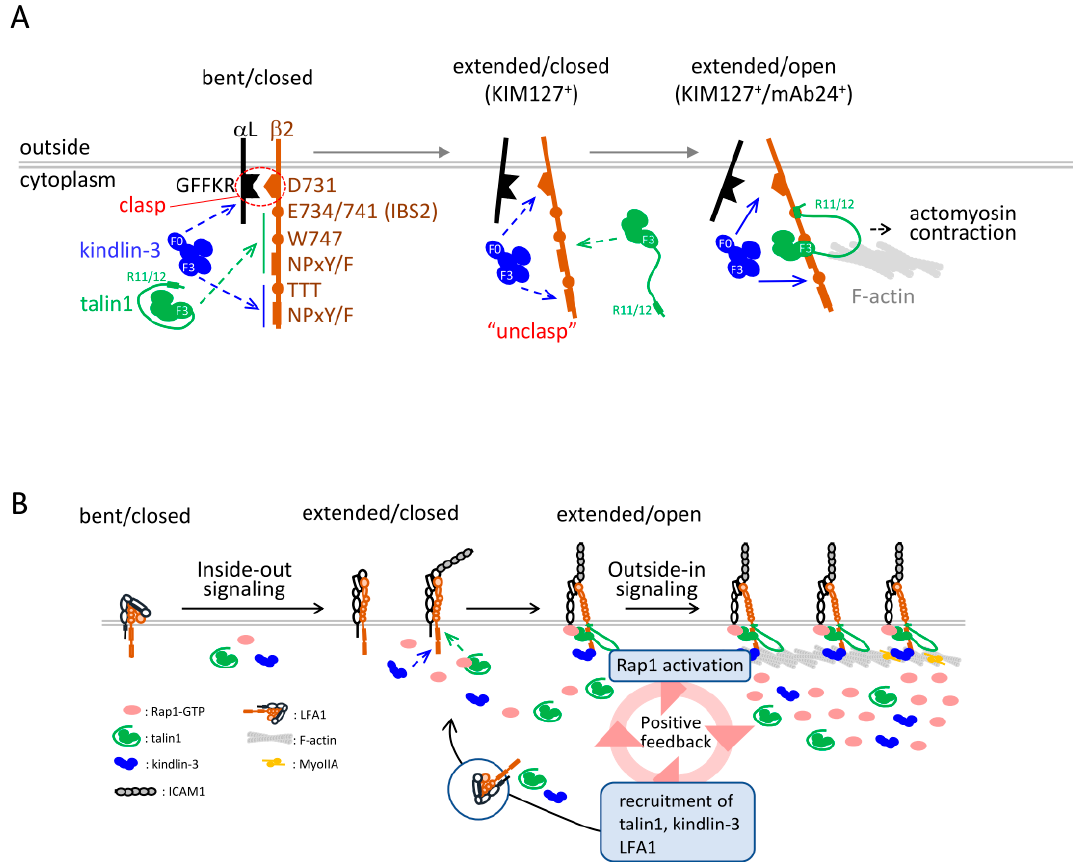
Figure 4. LFA1 activation processes. ( A ). Interactions of talin1 and kindlin-3 and cytoplasmic tails of LFA1. Critical residues in cytoplasmic tails that interact with talin1 and kindlin-3 are shown. Interactions of talin1 and kindlin-3 with the β 2 tail infrequently occur with a lifetime less than 1 s. Stimulation with PMA or chemokines induce unbending (KIM127 + ), and tend to increase the number of sub-second interactions of talin1 and kindlin-3. ICAM1 triggers conformational changes (mAb24 + ) concomitant with increased longer bindings of talin1 and kindlin-3. Kindlin-3 loosens α / β clasps and stabilizes talin1 bindings to the β 2 tail through IBS1 (F3), IBS2 (R11/12), and a linkage with actomyosin [102]. ( B ). Positive feedback of LFA1 activation. Once the extended-open headpiece with high-affinity ICAM1-bound LFA1 is formed, the outside-in signaling amplifies Rap1 signaling for the recruitment of talin1/kindlin-3 and LFA1 to growing attachment sites, thereby increasing the probability of co-occupancy with ICAM1 and integrin adaptors [102]. Adapted with permission from [102]. Copyright © 2022, AAAS.